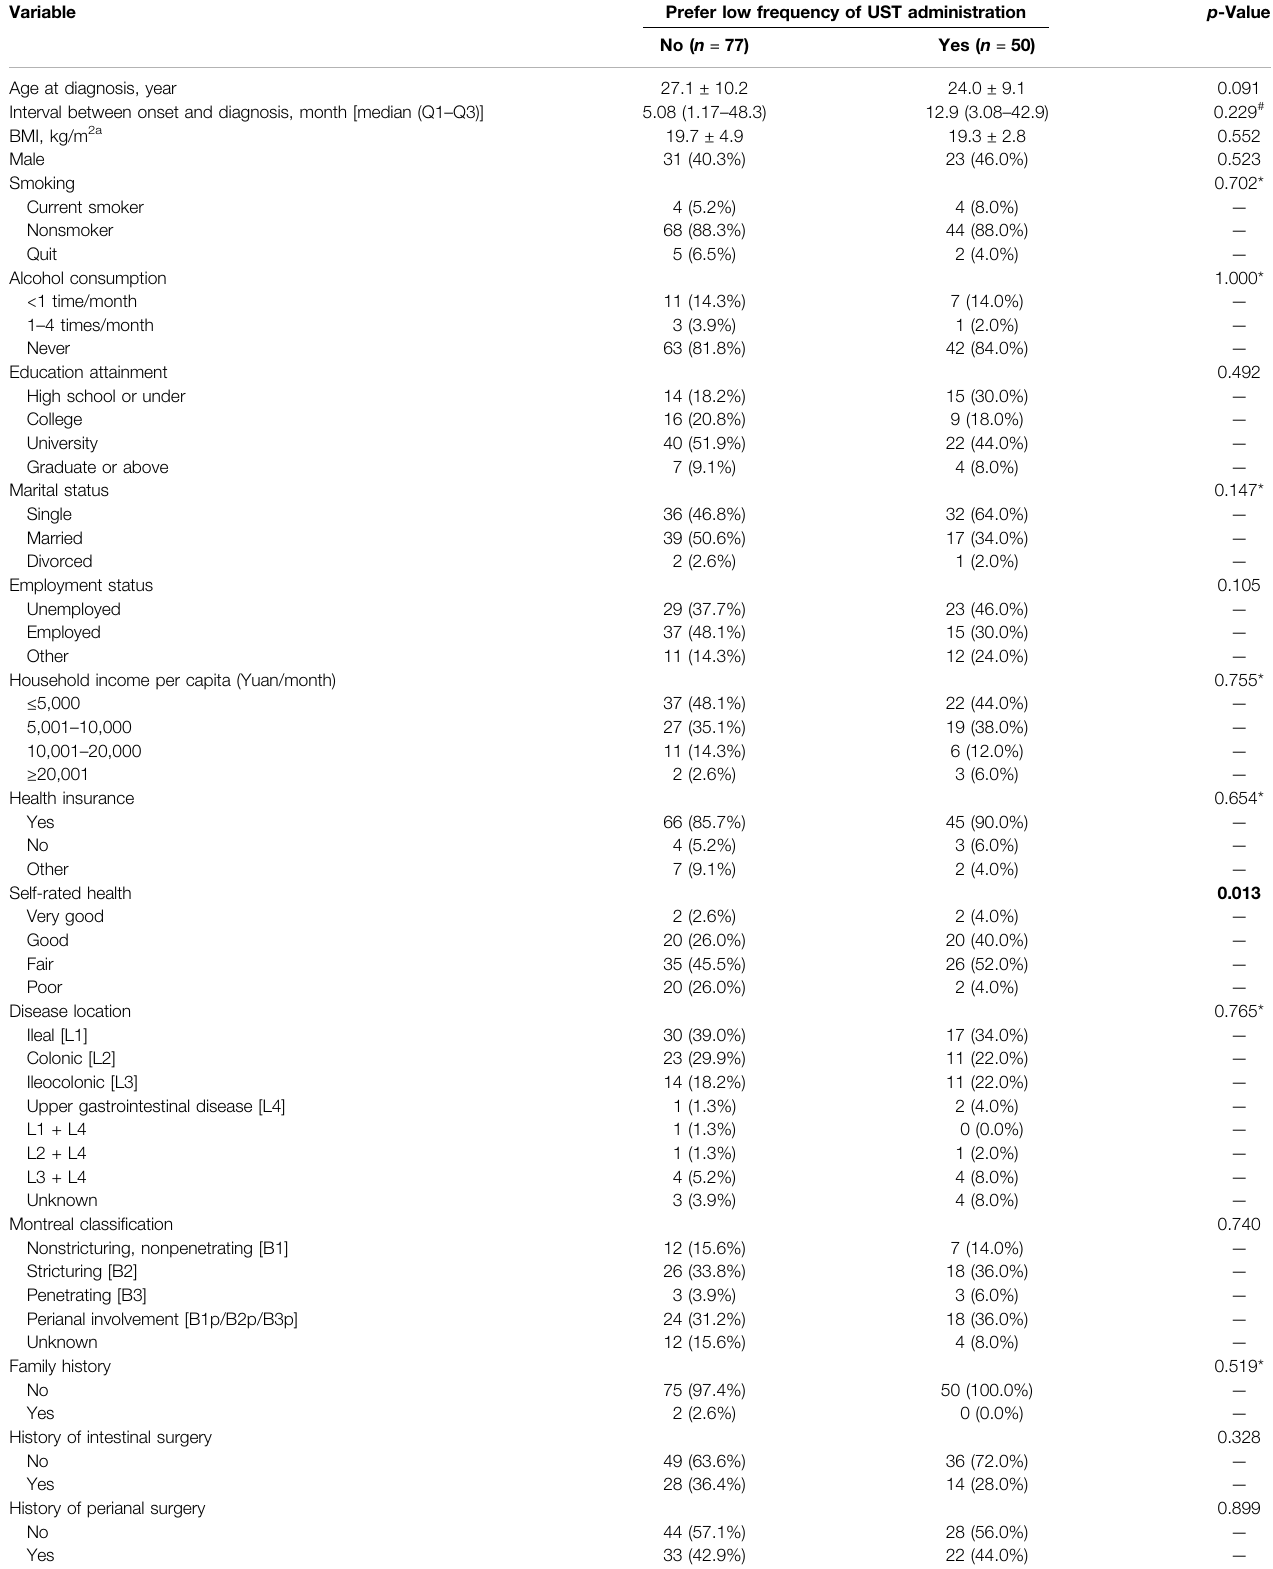
TABLE 4 | Characteristics of participants with different preference toward frequency of UST